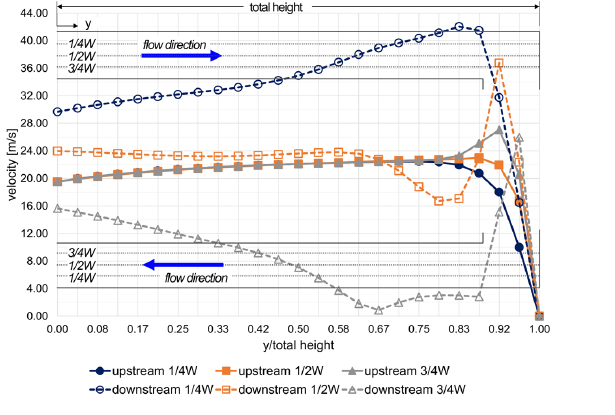
Figure 10. Flow characteristics of the turning region (Re = 24,230). 4.2. Results of Parameter and Optimization Studies 4.2.1. Response Surface A total of 15 design points for each Reynolds number were generated by CCD, and the calculations were performed using ANSYS Fluent. Figure 11 shows the local sensitiv- ity, which expresses the e ff ect of the input parameters of the design variables on the out- put of the TPLC at four Reynolds numbers. Among the three design variables, the divider tip-to-wall clearance had the most signi fi cant e ff ect on the TPLC; as the Reynolds number increased, the e ff ect of the channel width decreased, and the divider tip-to-wall clearance increased, but the divider width remained almost at the same level.